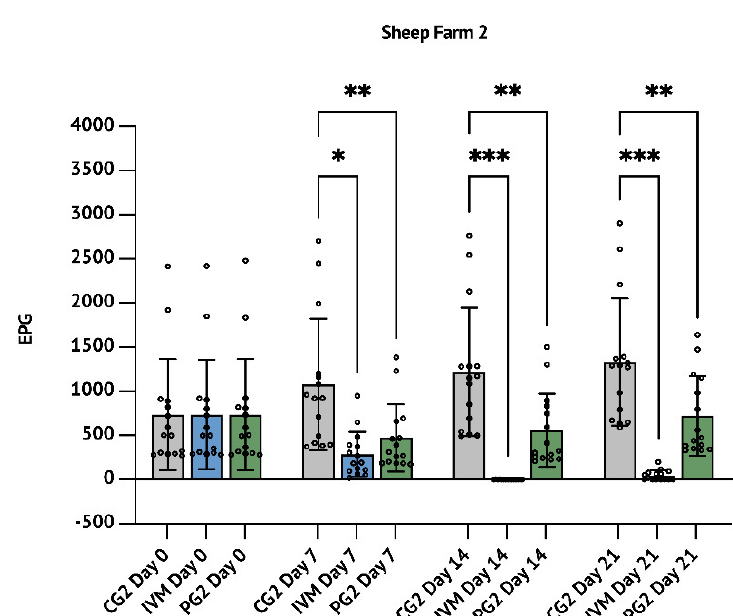
Figure 2. Sheep farm 2 (SF2): results concerning the comparison between the anthelmintic efficacy of aqueous P. granatum macerate with Ivermectin. The results are expressed as mean ± S.D. * p < 0.05, ** p < 0.01, *** p < 0.001.